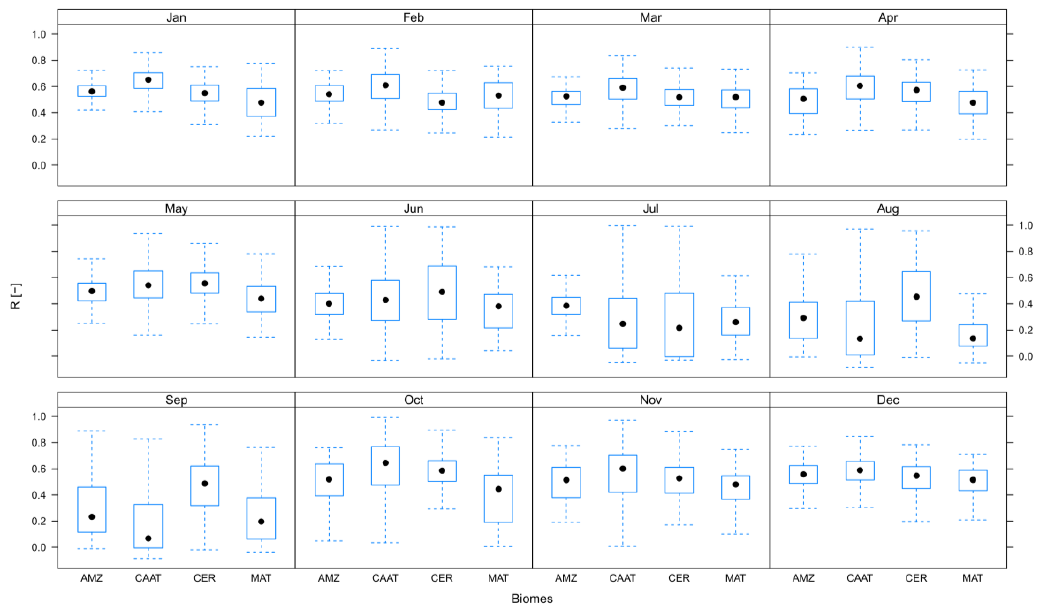
Figure 13. As per Figure 7, but for the CMORPH rainfall product during the period 2002 – 2015.